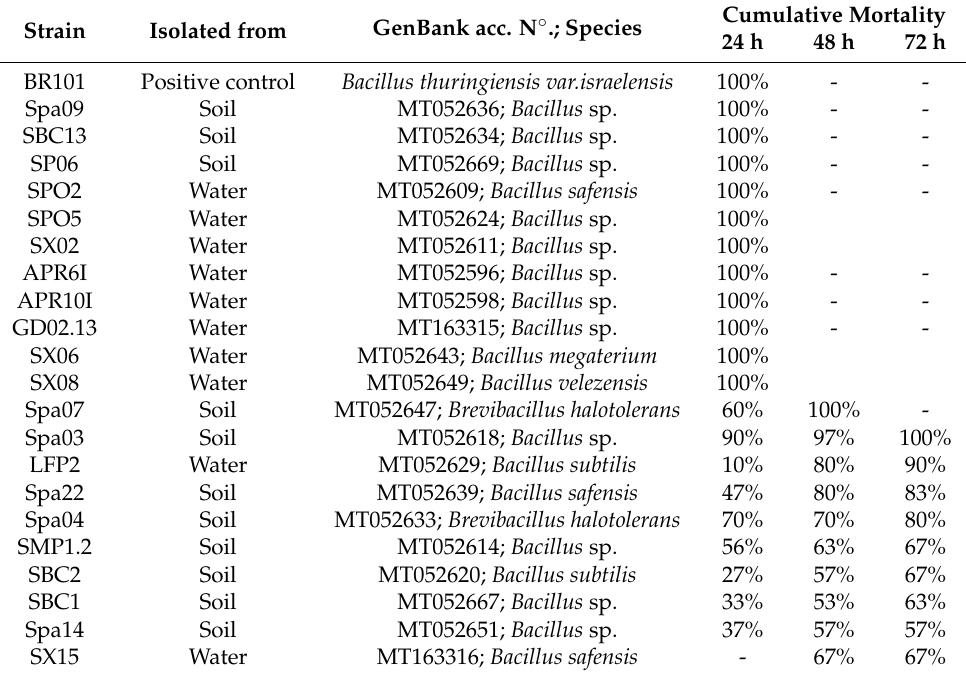
Table 2. Isolated strains with larvicidal activity against A. aegypti larvae.